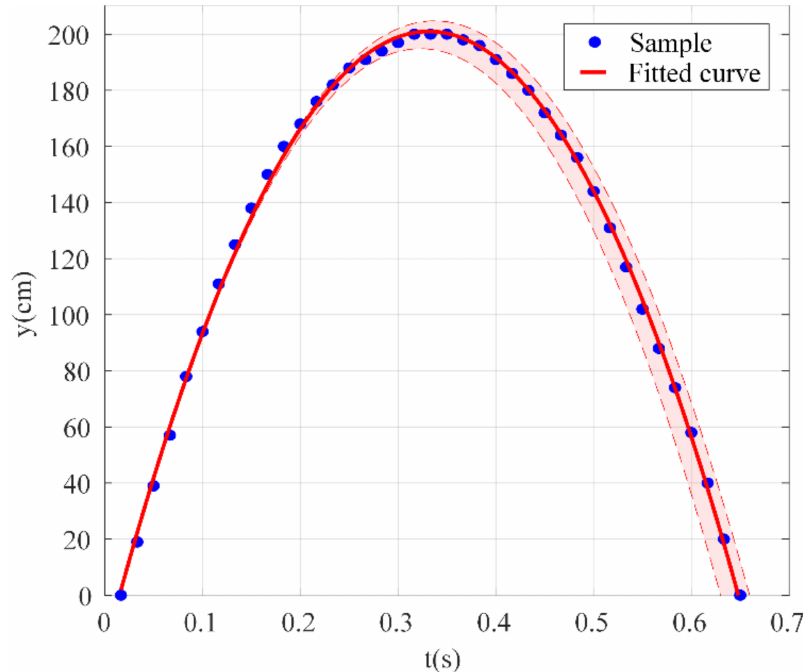
Figure 13. Sampled vertical displacement with curve-fitting